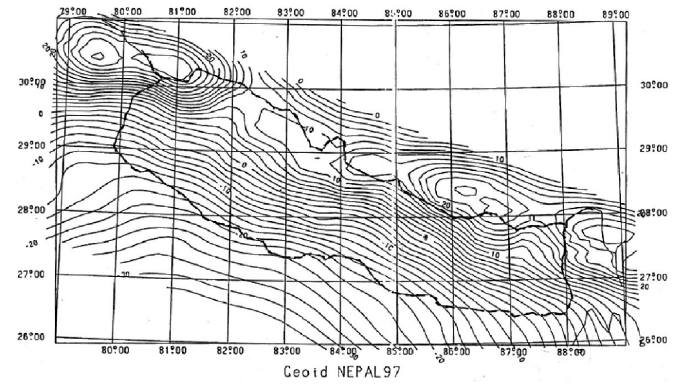
Figure 14. Geoid NEPAL97 by WNTMP 1997 [5,48].